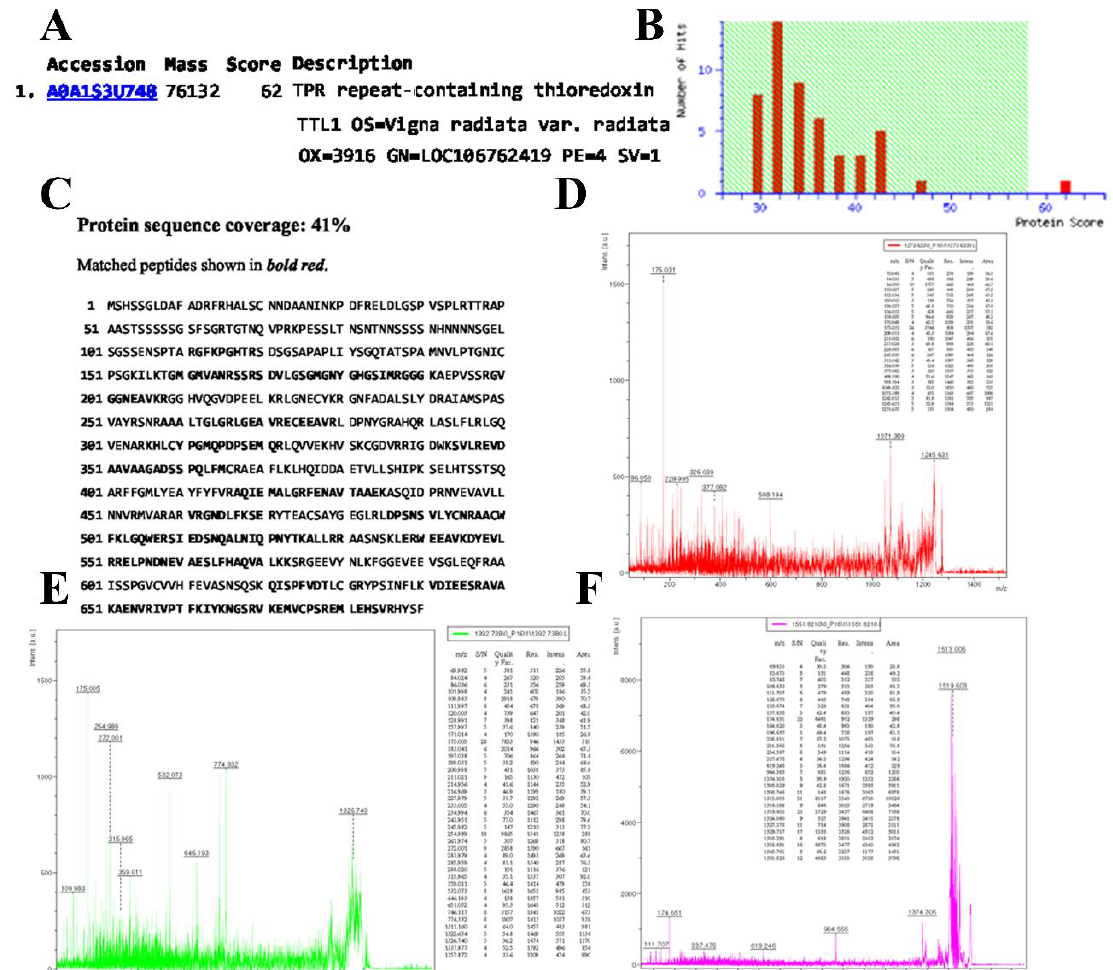
Figure 7. Total protein estimation in the selected genotypes after CS. ( A ) Total protein extracts were separated in a SDS-PAGE. L1-Protein marker L2-G77 at CC, L3-G77 at CS, L4-G88 at CC,L5-G88 at CS,L6-G92 at CC, L7-G92 at CS. Black arrow in L2 and L3 indicate B1 (~75kDa) from G77. Red arrow in L5 indicate B2 (~70 kDa) from G88 ( B ) total protein quantification was carried out using amido black method from 8-day-old seedlings grown at CS. G77, G88 and G92 are the genotypes, PAU911, PUSA1672 and PUSA9531 respectively. Statistical significance using one-way ANOVA indicated as ns: Non-significant.